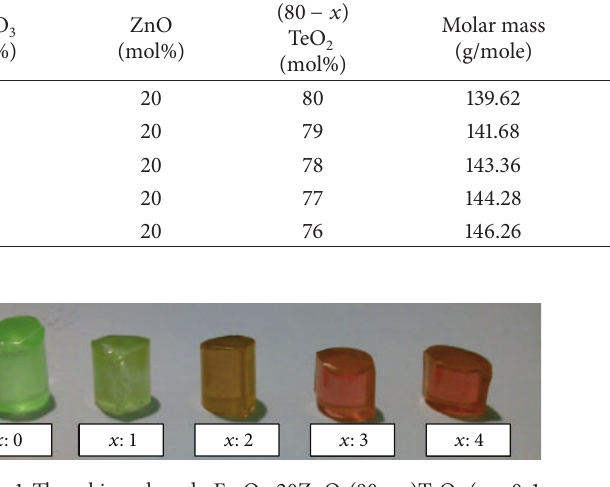
Figure 1: The erbium doped 𝑥 Er 2 O 3 -20ZnO-( 80−𝑥 )TeO 2 ( 𝑥 = 0, 1, 2, 3, and 4mol%) (EZT) glass samples.